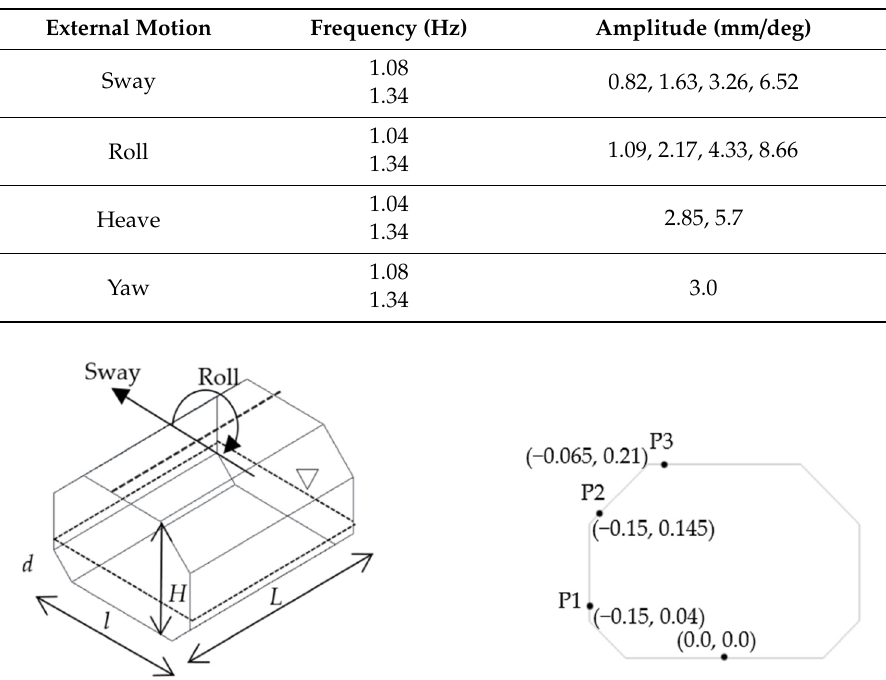
Table 1. Experimental conditions.